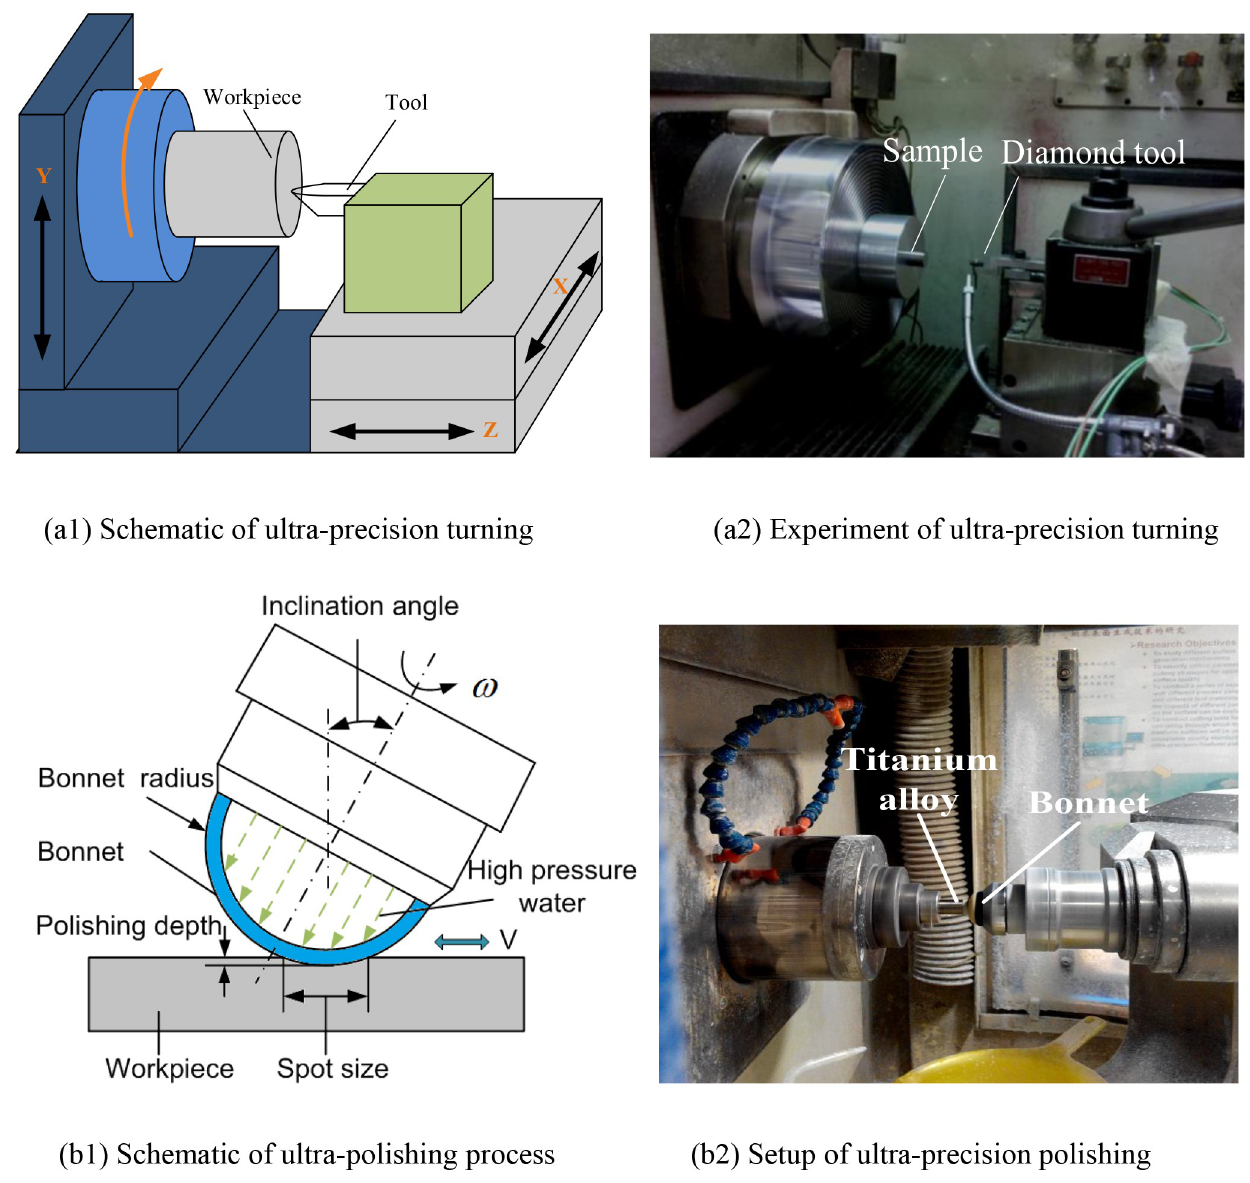
Fig 1. Ultra-precision turning and polishing of titanium